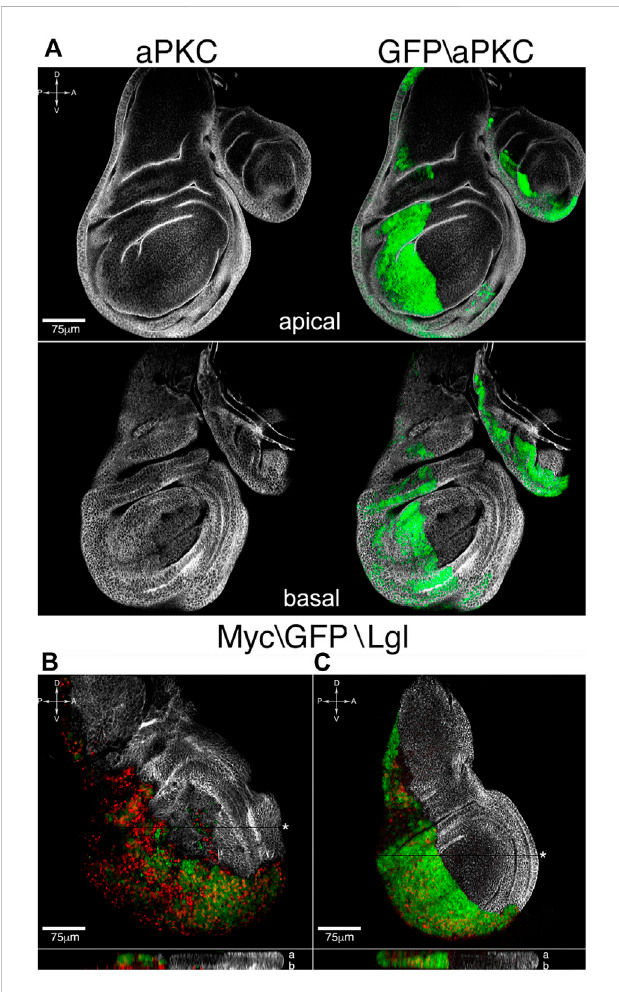
FIGURE 4 Apoptosis inhibition rescues tissue structure and cell migration. (A) Apical and basal sections of en -lgl KD , myc OVER , dIAP1 OVER wing discs showing normalization of tissue architecture and restriction border function. (B,C) Lgl (white) and Myc (red) staining of en -lgl KD , myc OVER , dIAP1 OVER wing discs (C) compared to en -lgl KD , myc OVER counterparts (B) . The reconstruction along the z axis shown at the bottom of each sample displays Myc-expressing nuclei going basal respect to GFP nuclei in (B) , while they colocalize in (C) . See Supplementary Table S1 for plain genotypes. All the images represent disc cross-sections; for xz images, the chosen section is indicated by a black stripe marked by an asterisk. In the z reconstructions, “ a ” and “ b ” stand for “ apical ” and “ basal ” . Scale bars and A, p , D and V compartments are indicated for each